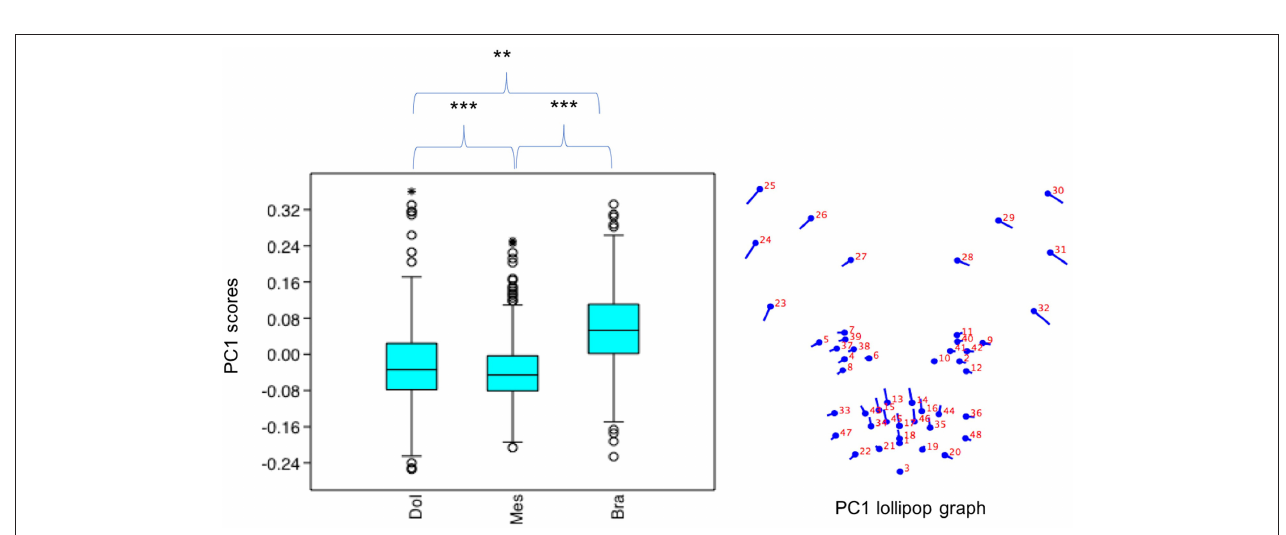
FIGURE 2 | Boxplot with minimum, first quartile, median, third quartile, maximum values and outliers for PC1 scores for each of the cephalic types; Dol, dolichocephalic; Bra, brachycephalic; Mes, mesocephalic; n = 1888. ** p < 0.01, *** p < 0.001. Relative landmark variation for PC1 represented via lollipop graph. Lines protruding from each landmark indicate direction and magnitude of movement, with higher PC1 scores reflecting a greater distance along the line from the circular nodes. Images produced using MorphoJ, Version 1.06d